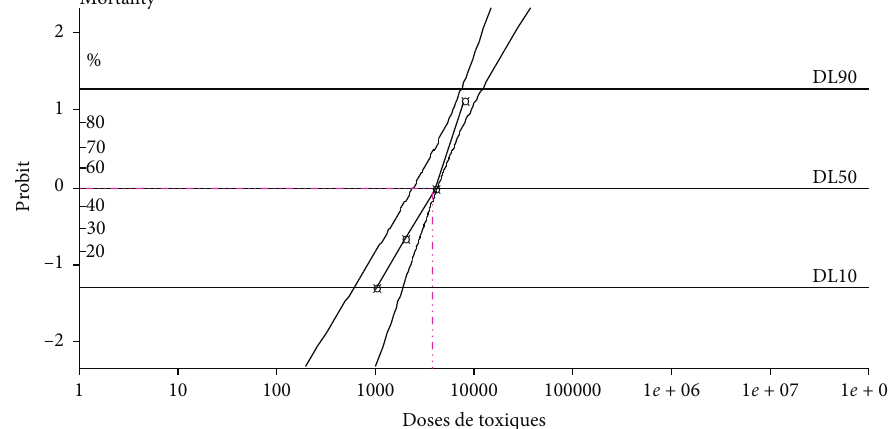
Figure 4: A graphic representation showing the LC 50 and LC 90 values of L. dentata spp. E. Oil after 24h of